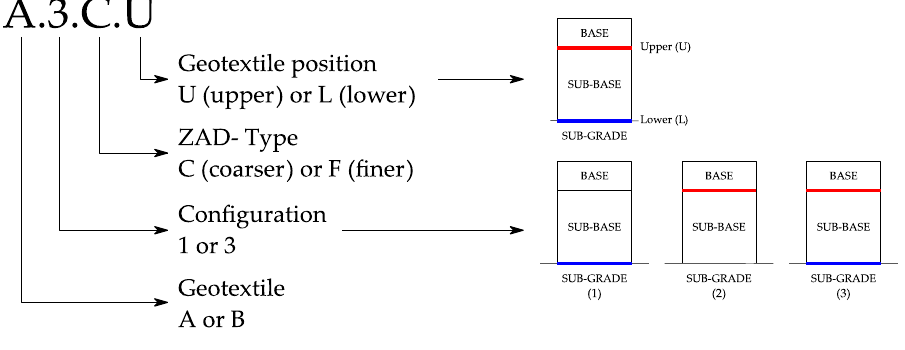
Figure 11. Test code explanation.